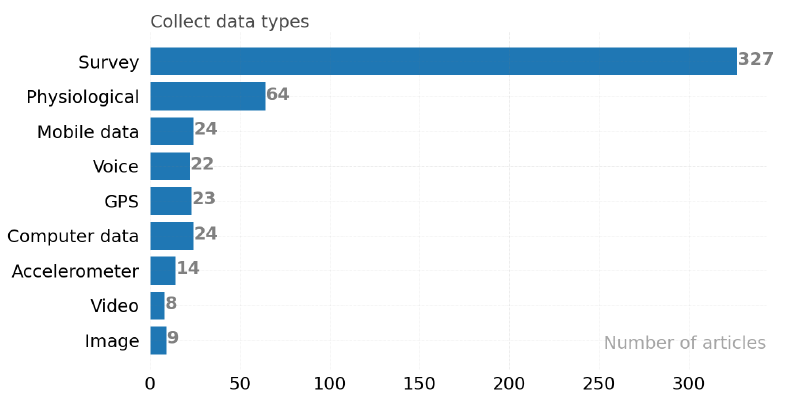
Figure 4. Types of data collected in articles.